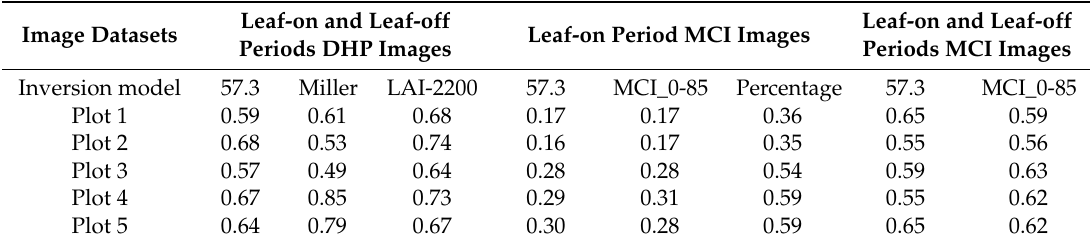
Table 5. α e estimates obtained from DHP and MCI in the five plots.